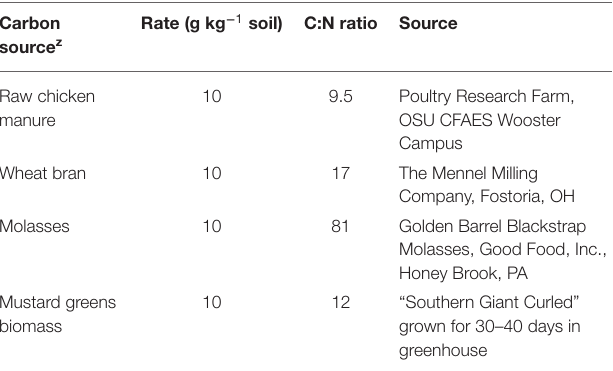
TABLE 1 | Characteristics of carbon sources for anaerobic soil disinfestation used in the experiments. Carbon source